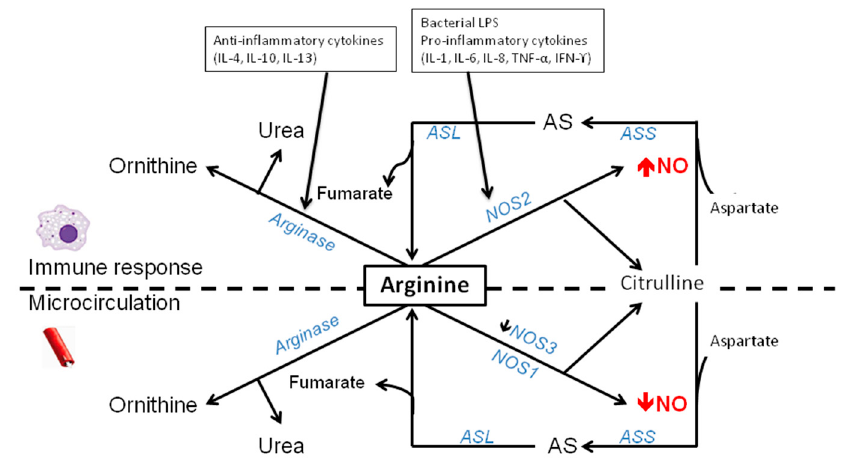
Figure 2. Arginine-citrulline-NO metabolism during inflammatory